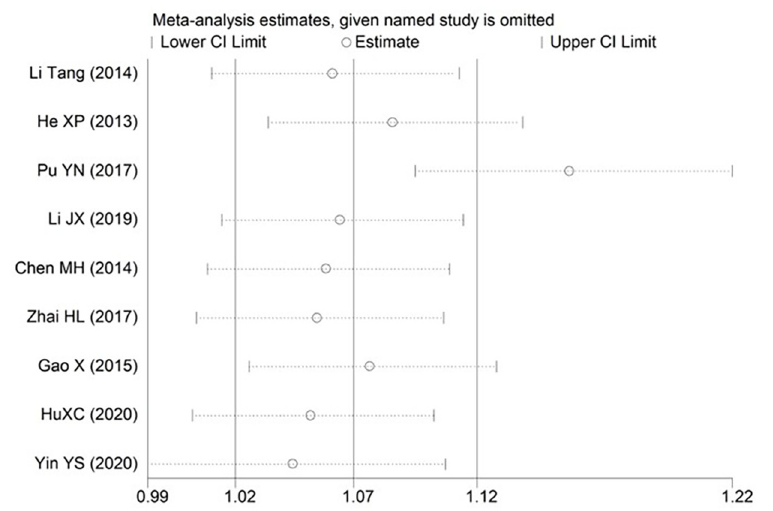
Fig 10. Sensitivity analysis for postpartum mood disorders.